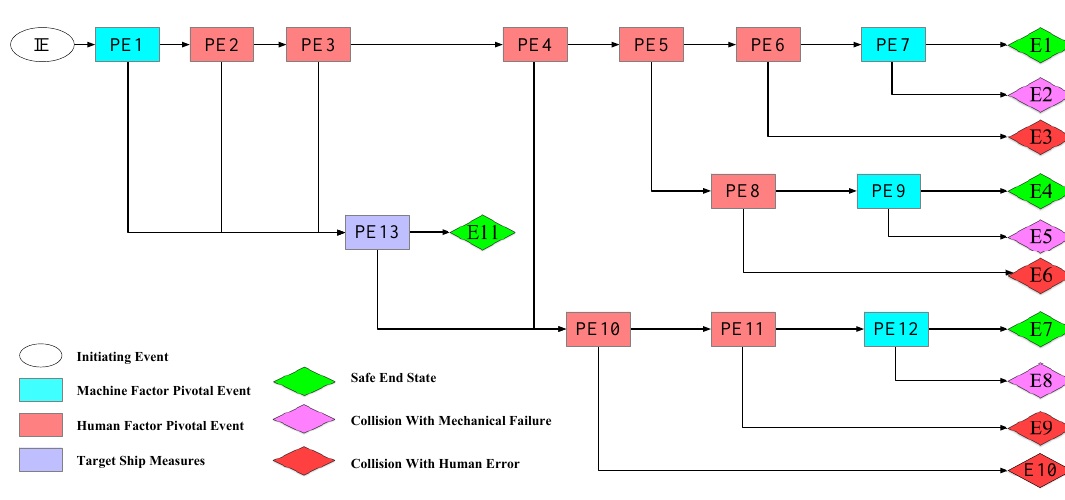
Figure 5. ESD of M-M ship collision scenario.